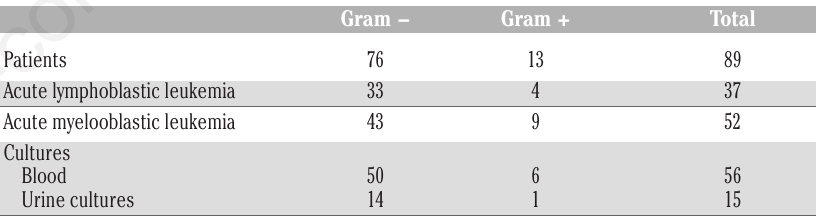
Table 1. Frequency of gram-negative and gram-positive bacterial infections in the study population.